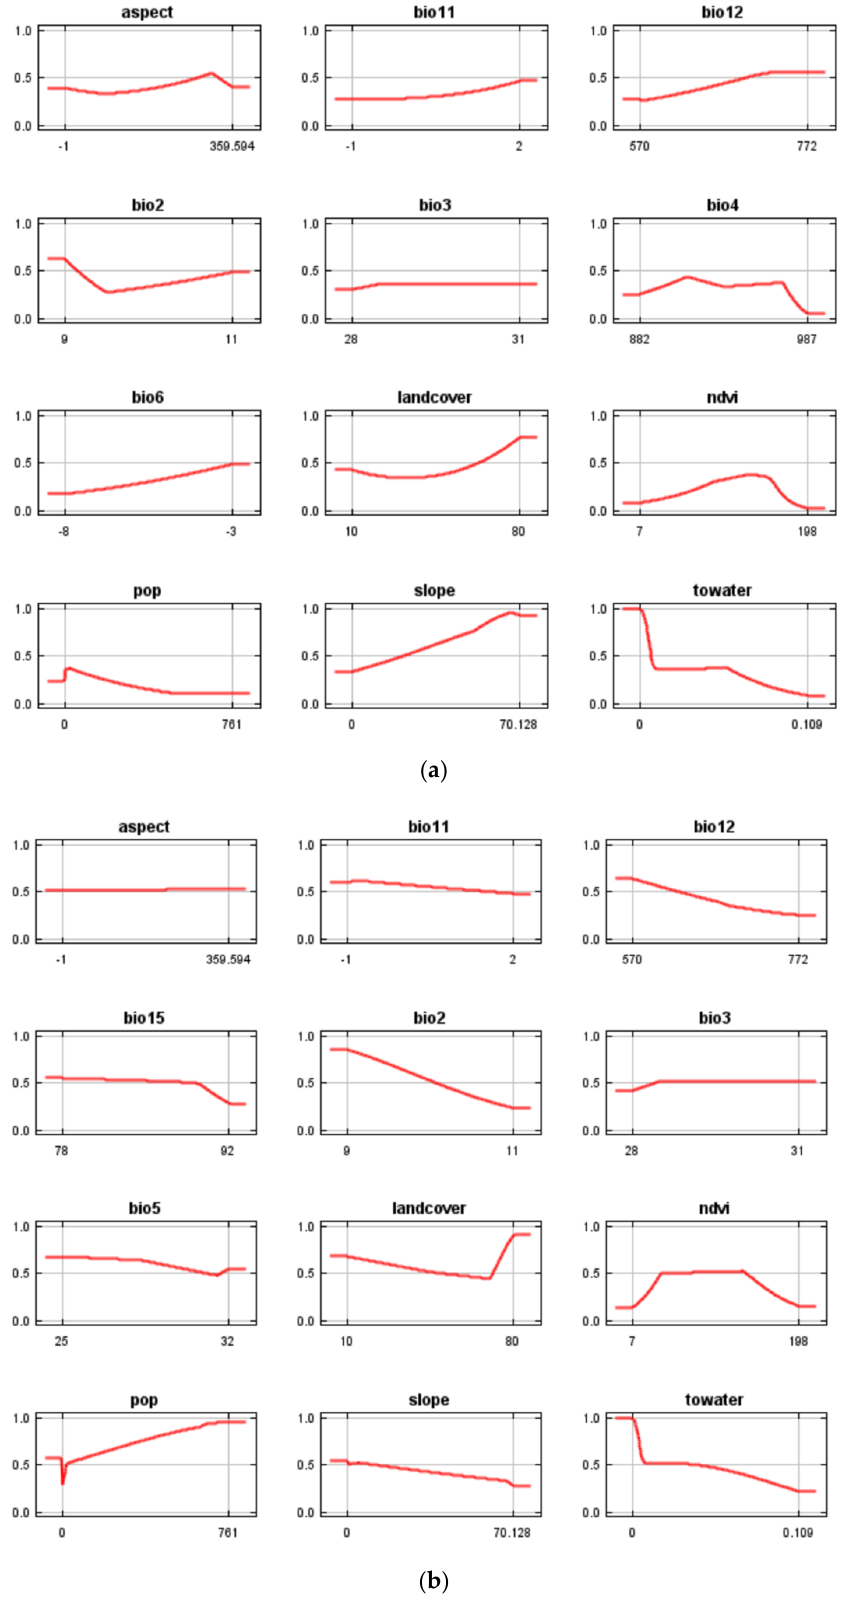
Figure A2. Response curves show how each variable affects the MaxEnt prediction. ( a ) Response curves for wetland plant distribution. ( b ) Response curves for waterfowl distribution.